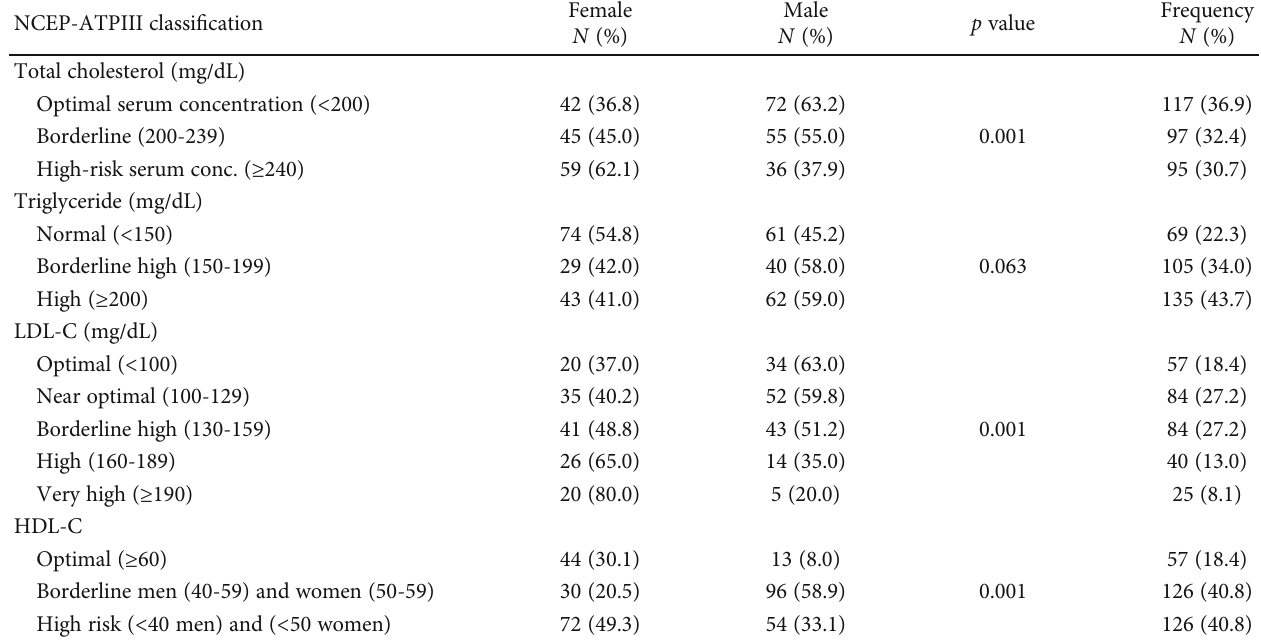
Table 3: Lipid pro fi le of DM patients at Halibet Regional Referral Hospital, in Asmara, Eritrea ( n = 309 ). NCEP-ATPIII classi fi